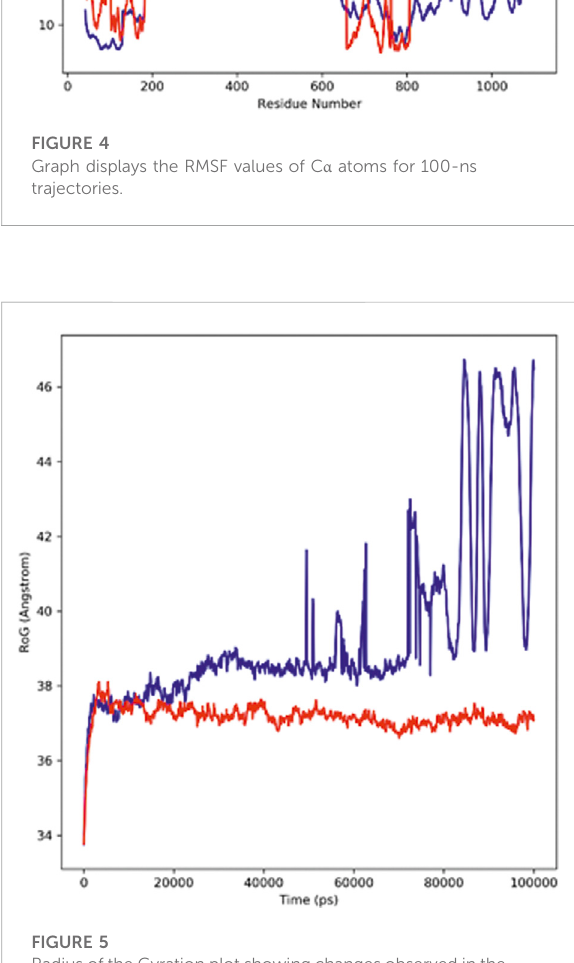
FIGURE 5 Radius of the Gyration plot showing changes observed in the conformational behavior of protein – ligand complexes (red depicting the hTERT – adapalene complex, while blue indicating the hTERT – tamsulosin complex) for 100-ns MD